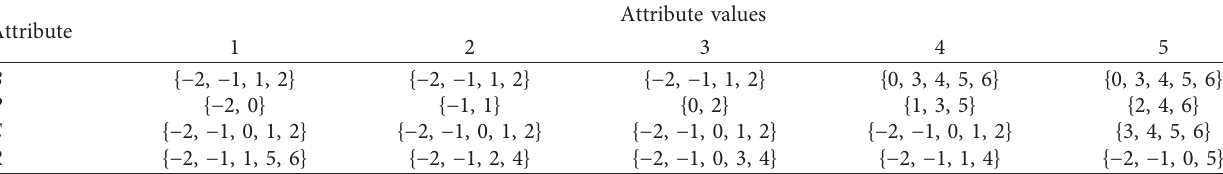
Table 3: Support sets (presented in brackets) of the attribute values of the synthetic dataset.